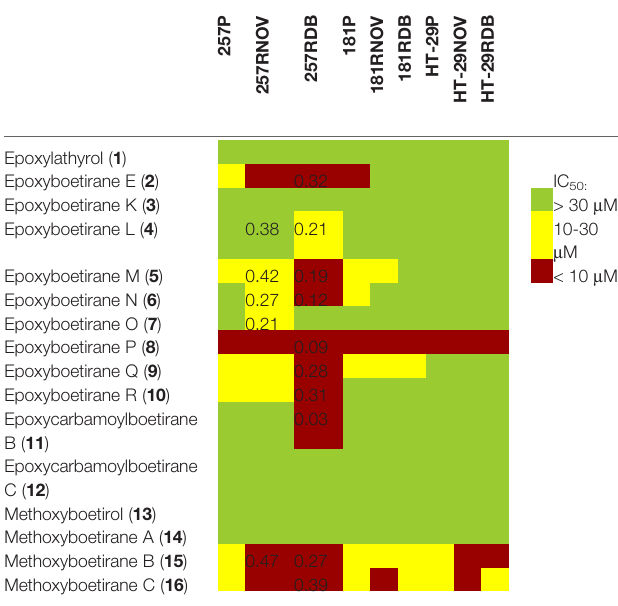
TABLE 1 | Heat map table summarizing the antiproliferative and collateral sensitivity results against gastric carcinoma cells (EPG85-257P, EPG85- 257RNOV, and EPG85-257RDB), and pancreatic carcinoma cells (EPP85-181P, EPP85-181RNOV, and EPP85-181RDB). This representation allows fi nding compounds that present MDR-selective activity at a determined IC 50 level. CS values (RR ≤ 0.5) are presented.